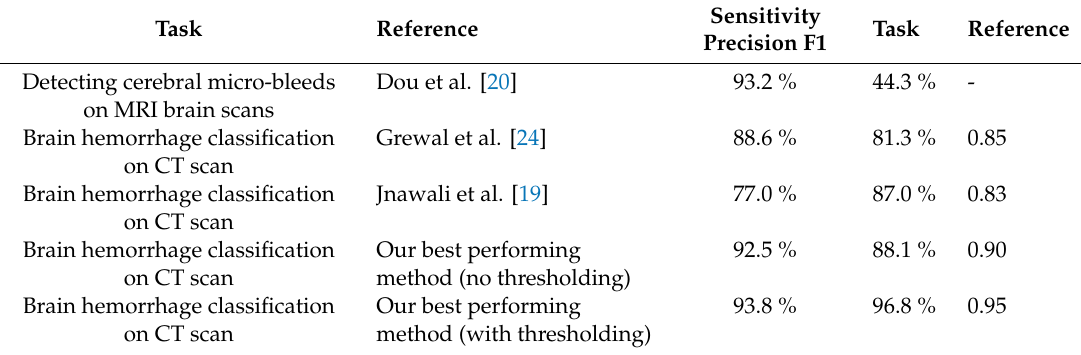
Table 5. Comparison of results involving brain hemorrhage detection in volumetric brain